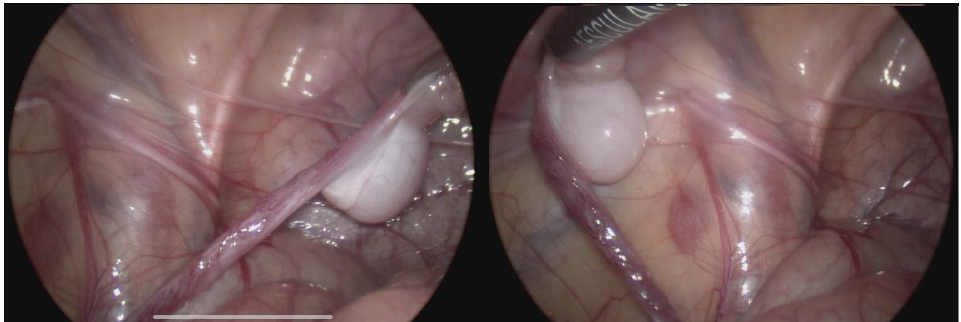
Figure 2. Testis with epididymis attached to testicular vessels but disconnected from the deferent duct. The distance between the internal inguinal ring and the crossing of testicular vessels from the retroperitoneal to the intraperitoneal positions was approximately 4 cm.